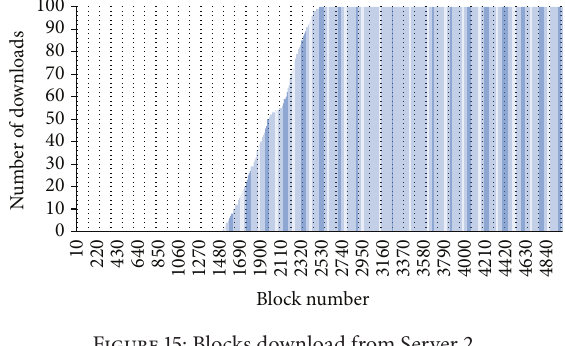
Figure 15: Blocks download from Server 2.